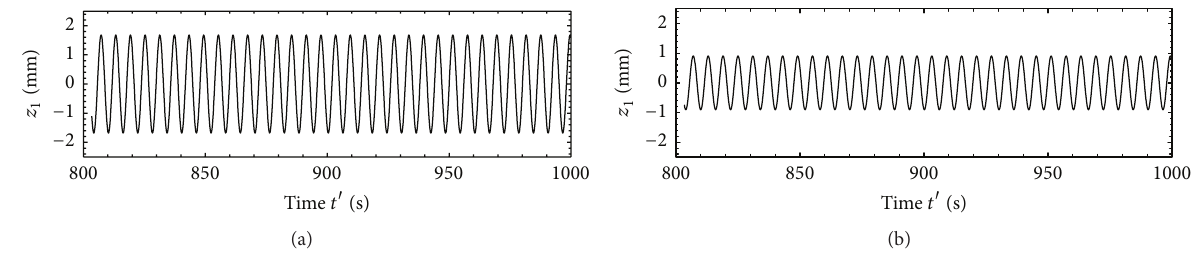
Figure 7: The time-series response when (a) 𝜏 = 0 and (b) 𝜏 = 1.1 as 𝜔 = 154